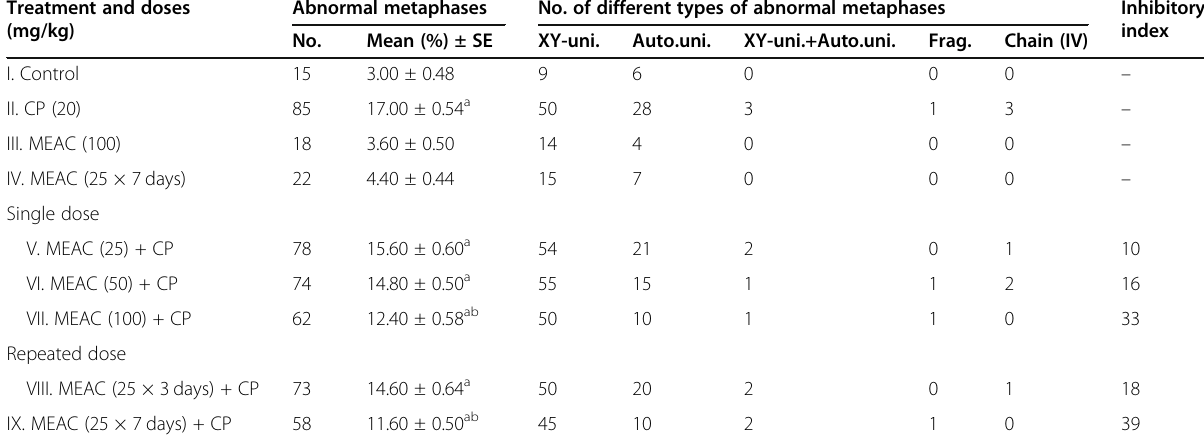
Table 2 Frequency of chromosomal abnormalities in mouse spermatocyte induced after treatment with CP and MEAC Treatment and doses (mg/kg)